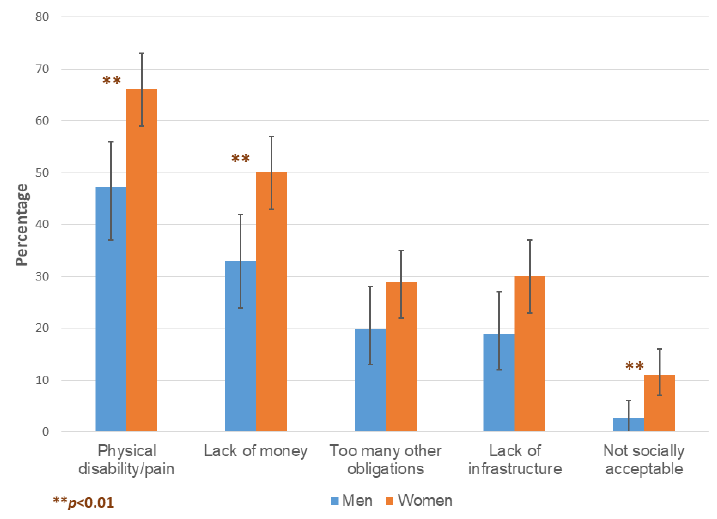
Figure 3. The reported barriers to implementing leisure physical activity (LPA) recommendations. The error bars represent 95% confidence intervals.